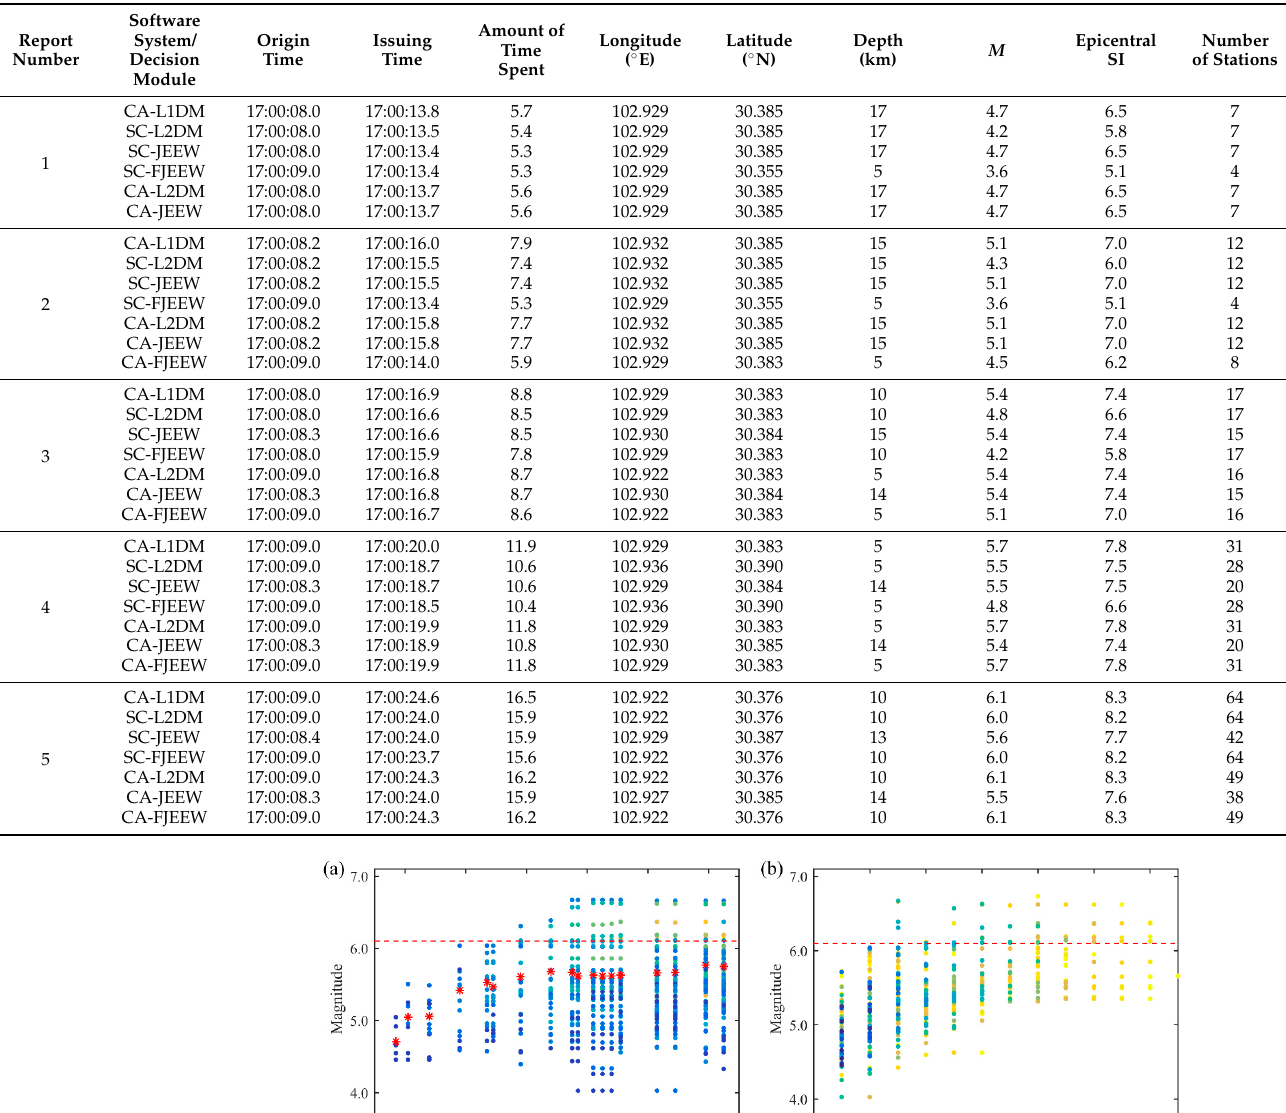
Table 2. Detail information of the real-time processing results of the Chinese national EEWS for the 2022 Lushan earthquake. Definitions of CA-L1DM, CA-L2DM, CA-JEEW, CA-FJEEW, SC-L2DM, SC-JEEW, and SC-FJEEW are the same as those in Figure 3.